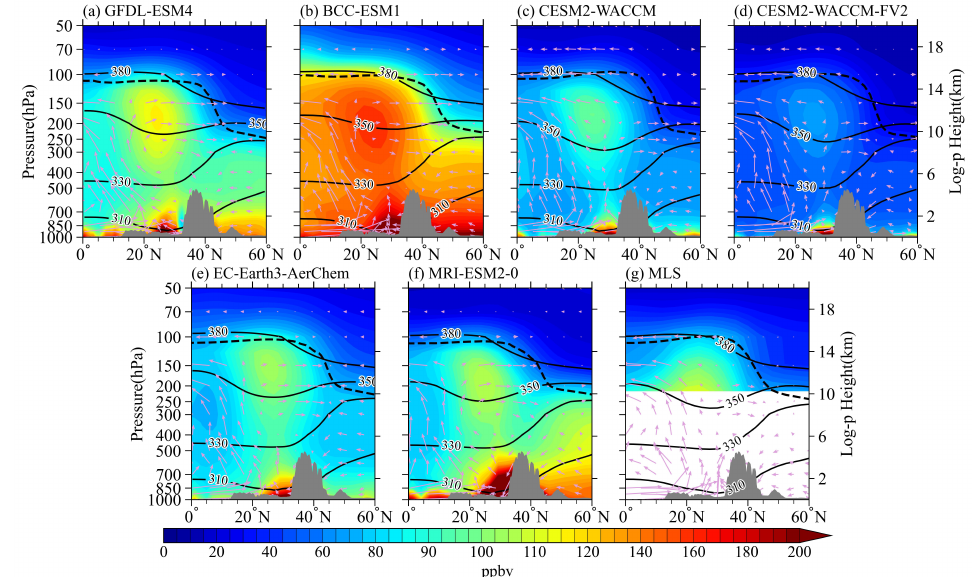
Figure 2. Latitude-height cross sections of JJA mean CO mixing ratio (color shaded, ppbv) between 30 ◦ –130 ◦ E during 2005–2014 JJA. Thin black solid lines are potential temperature. Thick black dashed lines represent the thermal tropopause. Purple arrows indicate the wind fields. Grey shadings indicate topography. ( a – f ) are from models and ( g ) is from MLS and NCEP